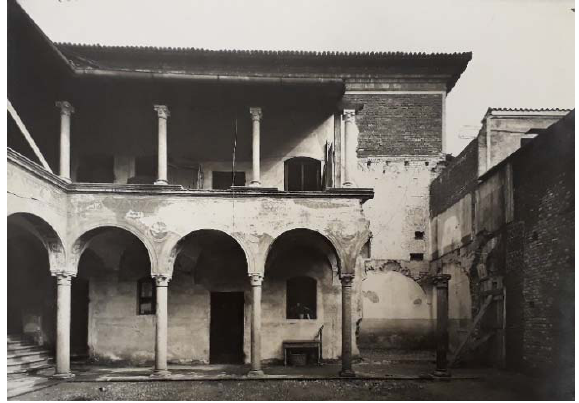
Figure 4. The Cloister of Priore, after the II World war, partially demolished even if not touched by bombs to develop a new entrance of the